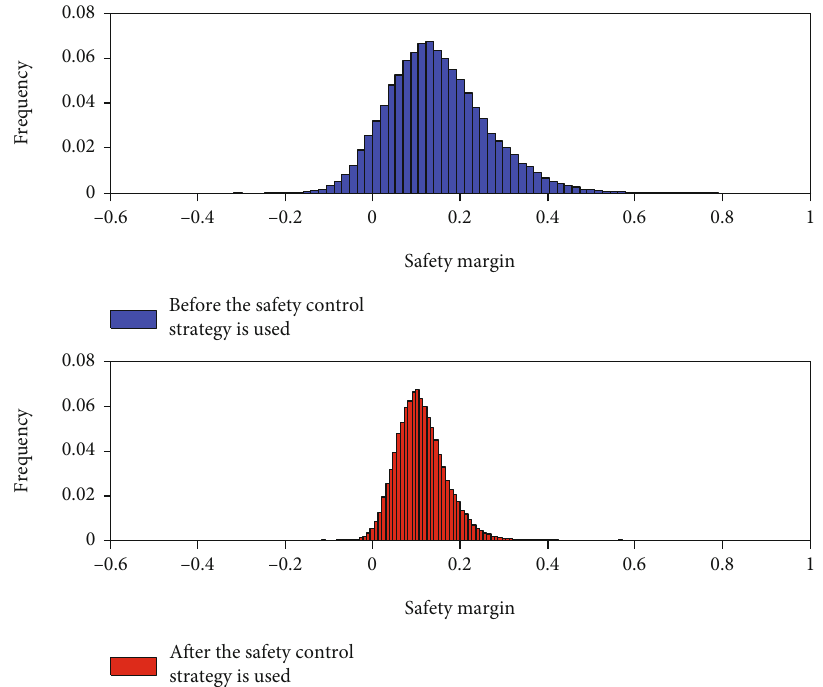
Figure 19: Probability distribution of the safety margin for the rotational speed Y